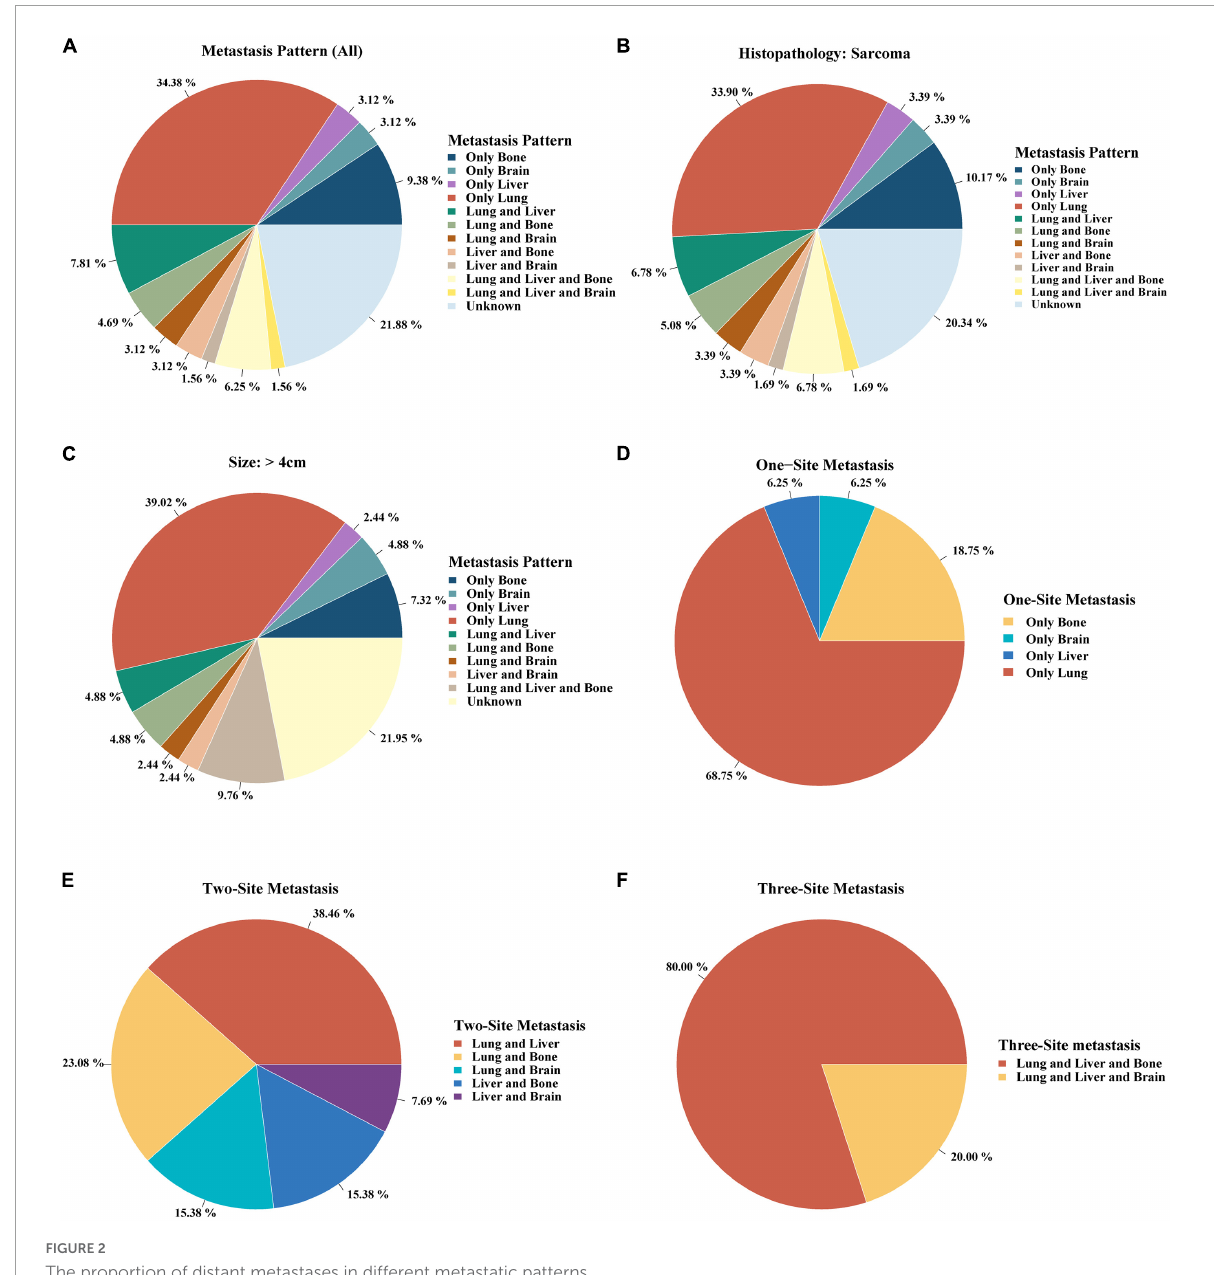
the sarcoma and large tumor size > 4 cm subgroups. As shown in Figures 2B,C , single lung metastasis was also the primary metastatic pattern in both sarcoma and large tumor size ( > 4 cm) (33.90 and 39.02%, respectively). Single metastasis occurred most frequently in the lungs (68.75%) ( Figure 2D ). Lung and liver metastases were the most common pattern of two-site metastases (38.46%) ( Figure 2E ). Three-site metastases occurred most frequently in the lung, liver, and bone (80%) ( Figure 2F ).